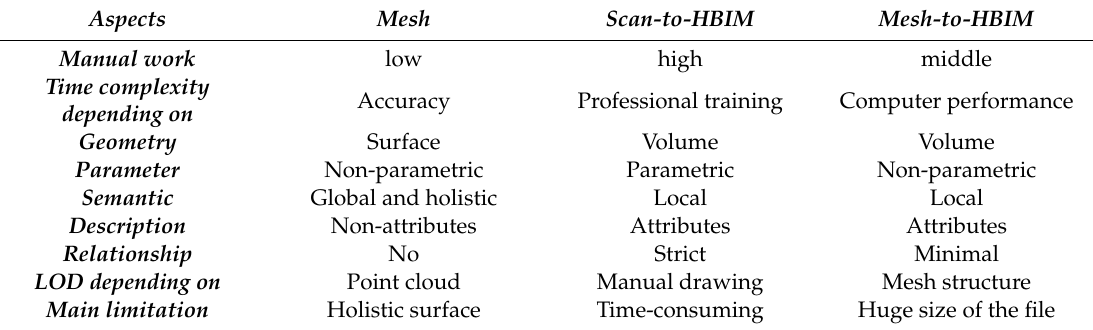
Table 1. Comparison among different heritage models.